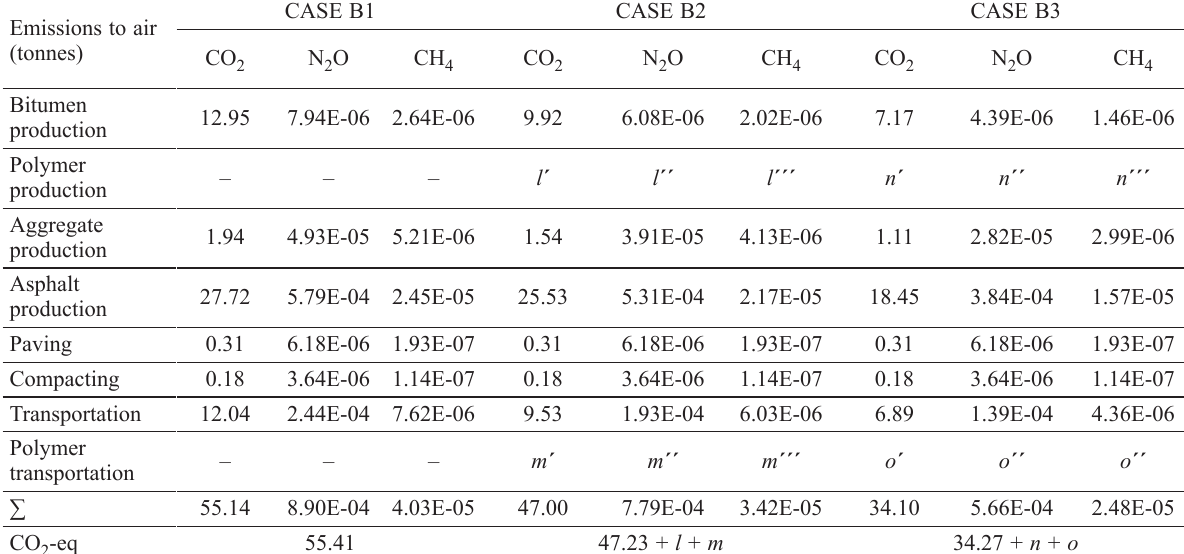
Table 6. Greenhouse Gases (GHGs) for Case study B per FU produced during different processes in the construction of the asphalt pavement Emissions to air (tonnes)